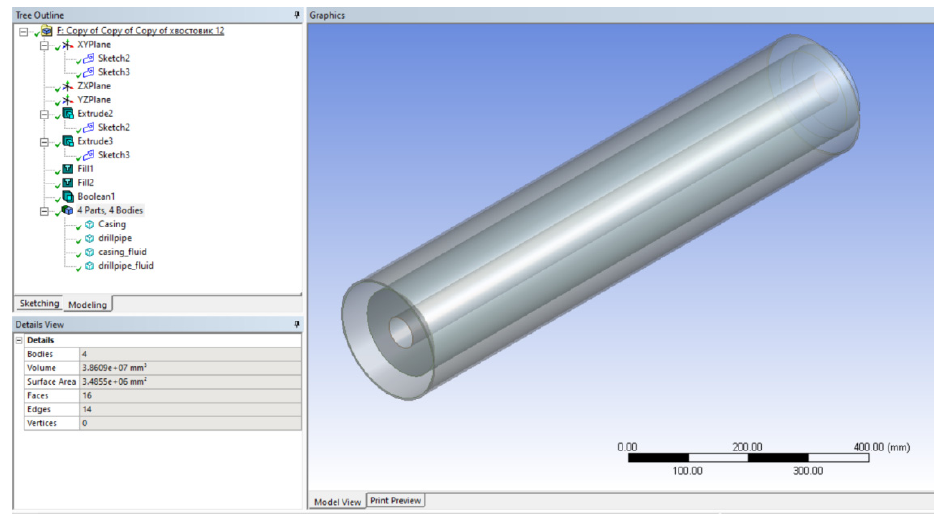
Figure A1. Base scheme of the well design .